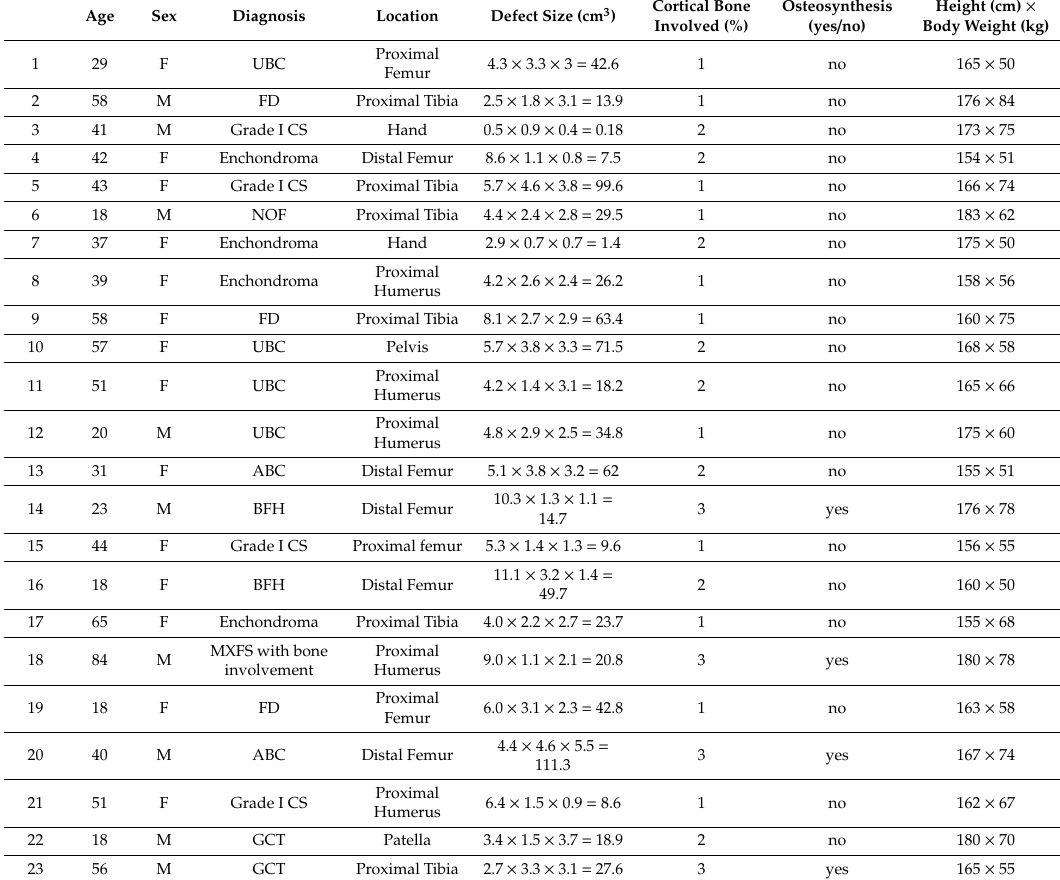
Table 2. Demographic data from patients included in the study. The seventh column refers to the percentage of bone involved in an MR or CT axial view. The following legend was applied: 0 points if intramedullary, 1 point when occupying less than 1 / 3 of bone diameter, 2 points if between 1 / 3 and 2 / 3 of bone diameter, and 3 points when involving more than 2 / 3 of bone